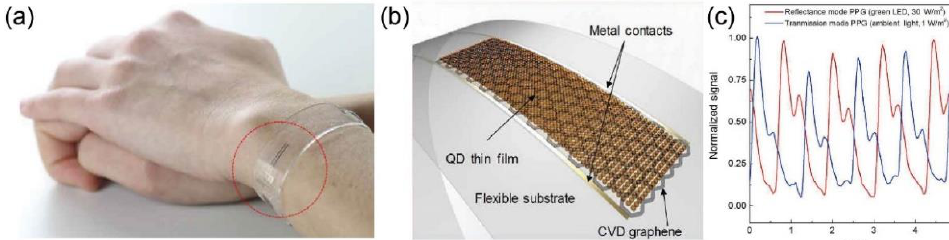
Figure 9. ( a ) Photograph of the flexible and transparent GQD PD attached to a bracelet-shaped wrist that can monitor heart rate. ( b ) Schematic illustration of the assembly of graphene and QDs on a flexible substrate. ( c ) Normalized PPG signal when the PPG sensor operates in transmission and reflection modes. With the high sensitivity and mechanical flexibility of the GQD PD, the health patch can operate accurately for long periods in transmission and reflection modes. Adapted with permission from [35], AAAS,